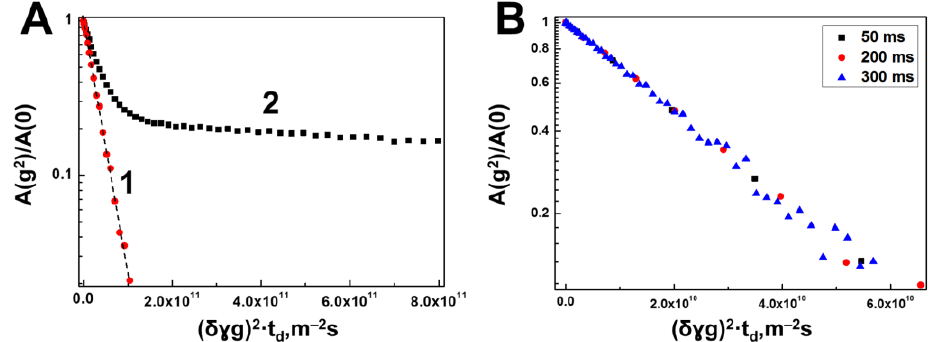
Figure 3. Diffusion decays of the spin echo signal for a mixture of BSA and HA obtained in the spectral resolution mode at a polysaccharide concentration of 0.75% and protein concentration of 4%. ( A ) Diffusion decays obtained at diffusion time of 50 ms by integrating the signals of the proton spectrum of a mixture of BSA and HA for the chemical shift regions from 6.6 to 8.2 ppm (curve 1), specific to BSA molecules, and for the chemical shift region from 1.8 to 3.9 ppm, in which there are signals from both HA and from BSA (curve 2). ( B ) Diffusion decays for BSA molecules at various diffusion times of 50, 200 and 300 ms, obtained by integrating signals in the range of chemical shifts from 6.6 to 8.2 ppm.